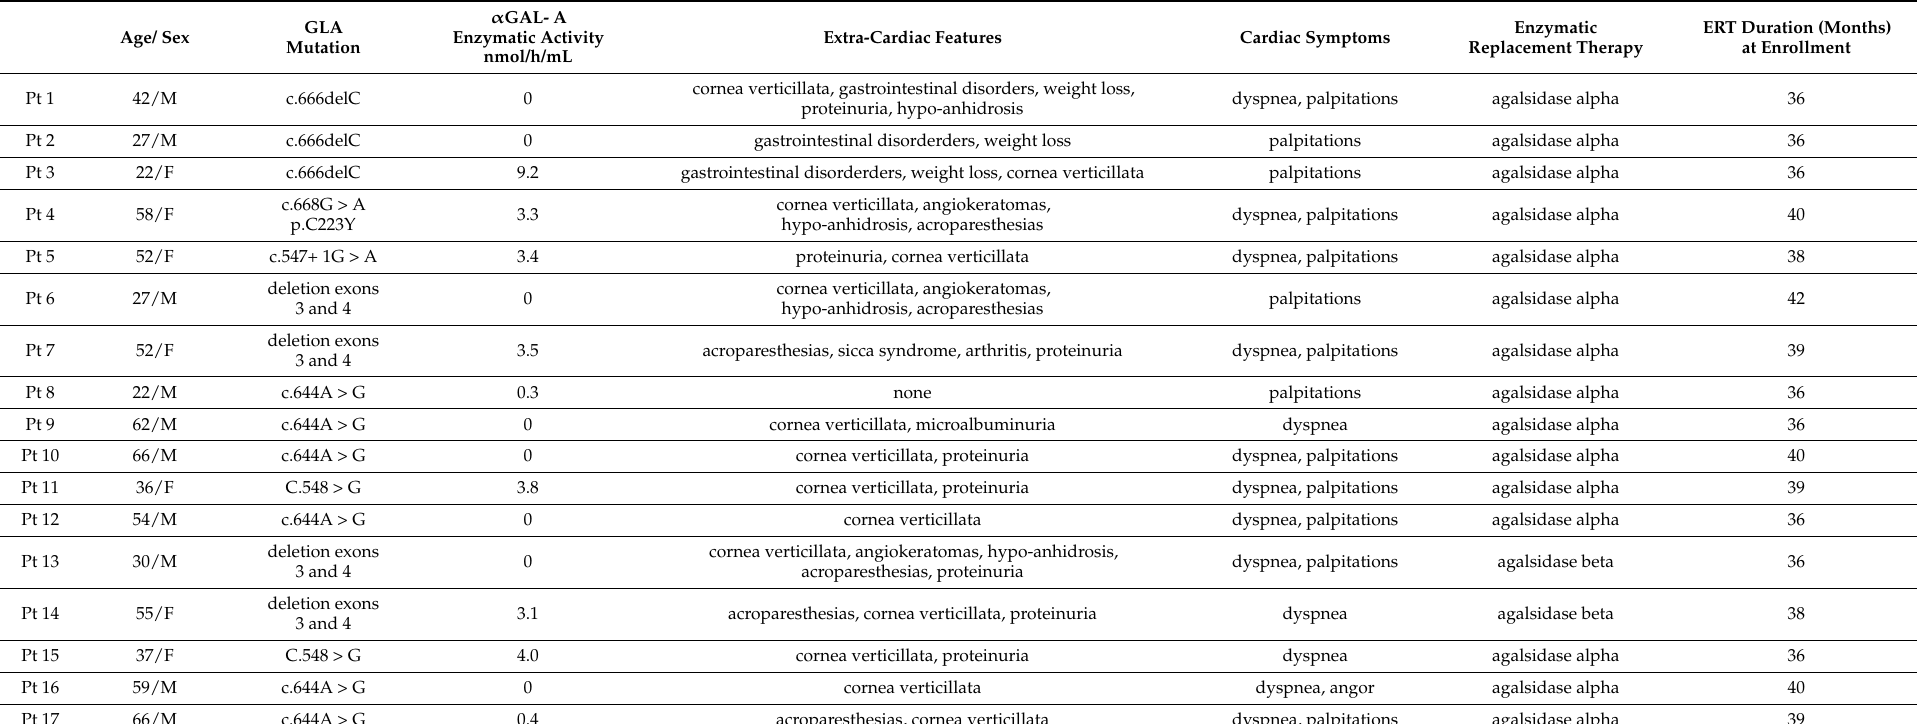
Table 1. Baseline clinical and genetic features of patient